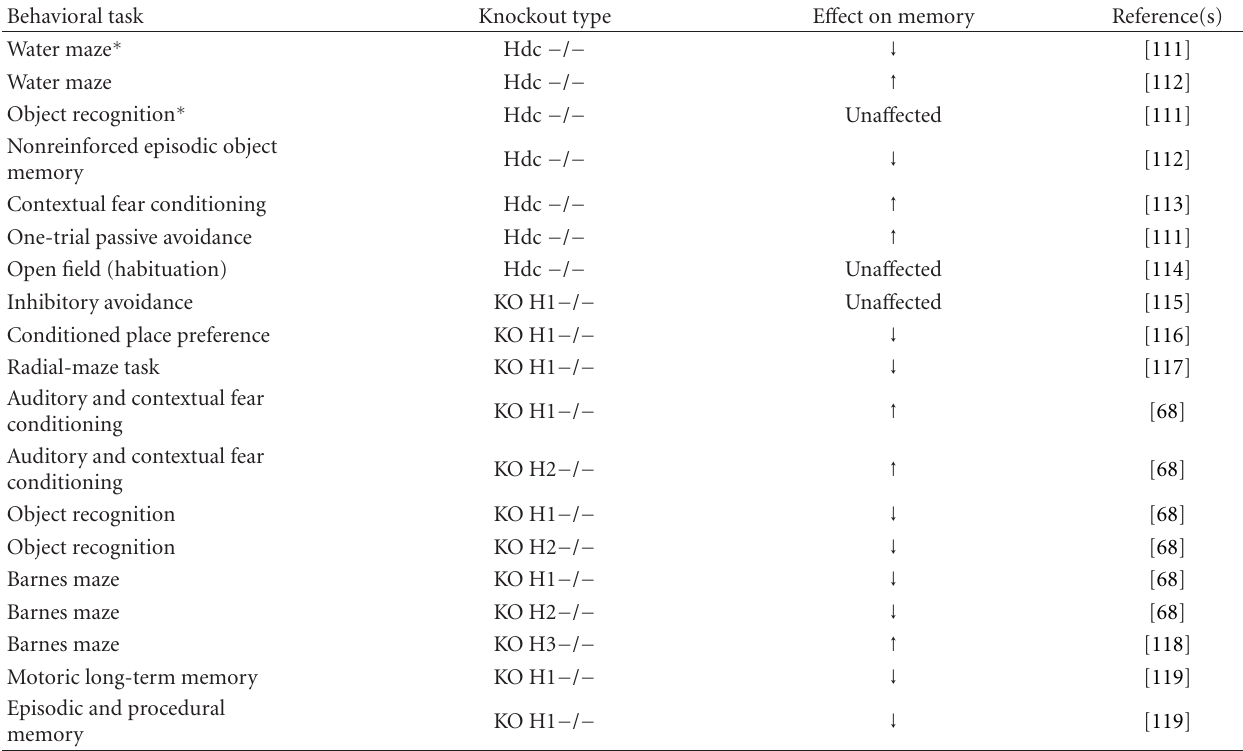
Table 2: Knockout mice models and memory